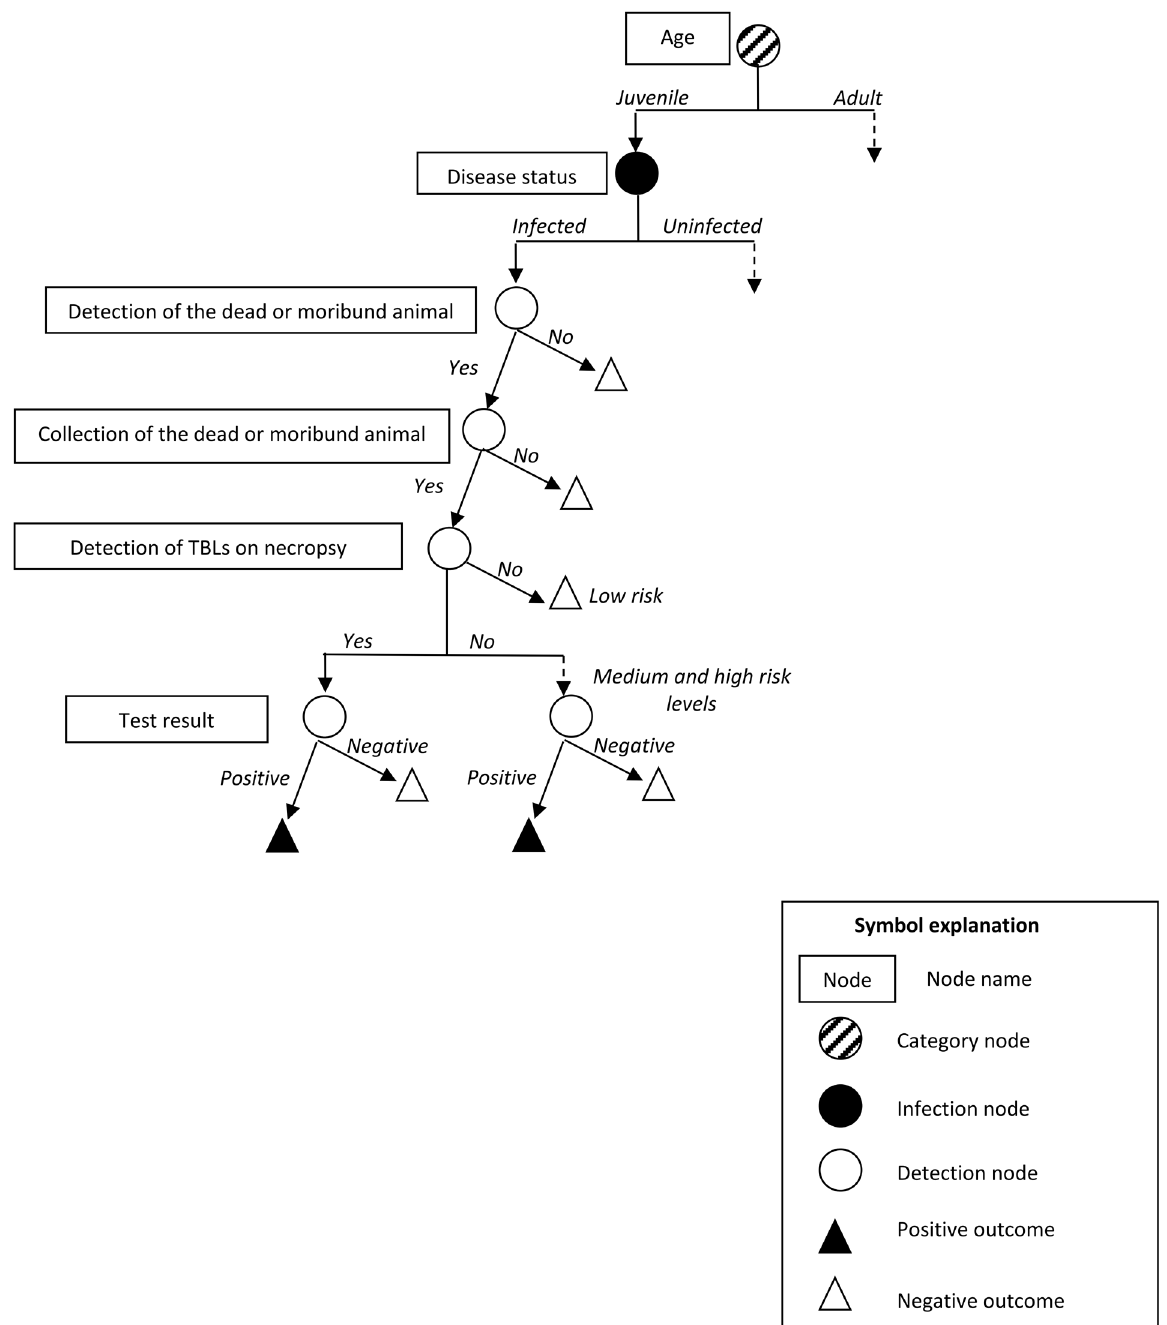
Fig 3. Scenario tree illustrating the surveillance system component for animals found dead, moribund or with abnormal behaviour (SAGIR-SSC, applied to each species and all risk